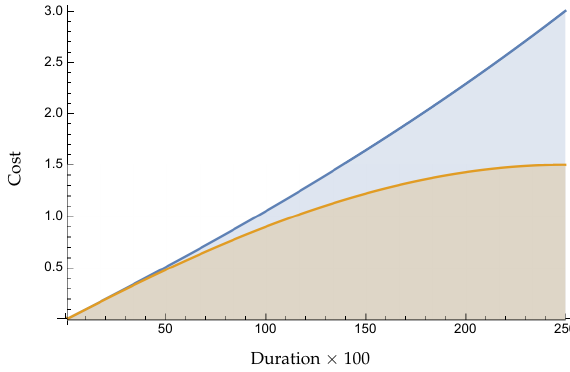
Figure 4. Cost of OFFLINE (Brown) and ONLINE (Blue).